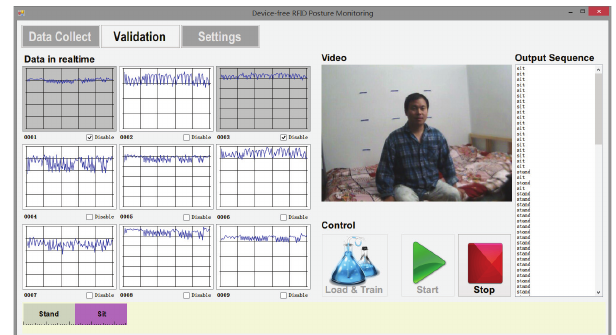
Figure 11: System interface